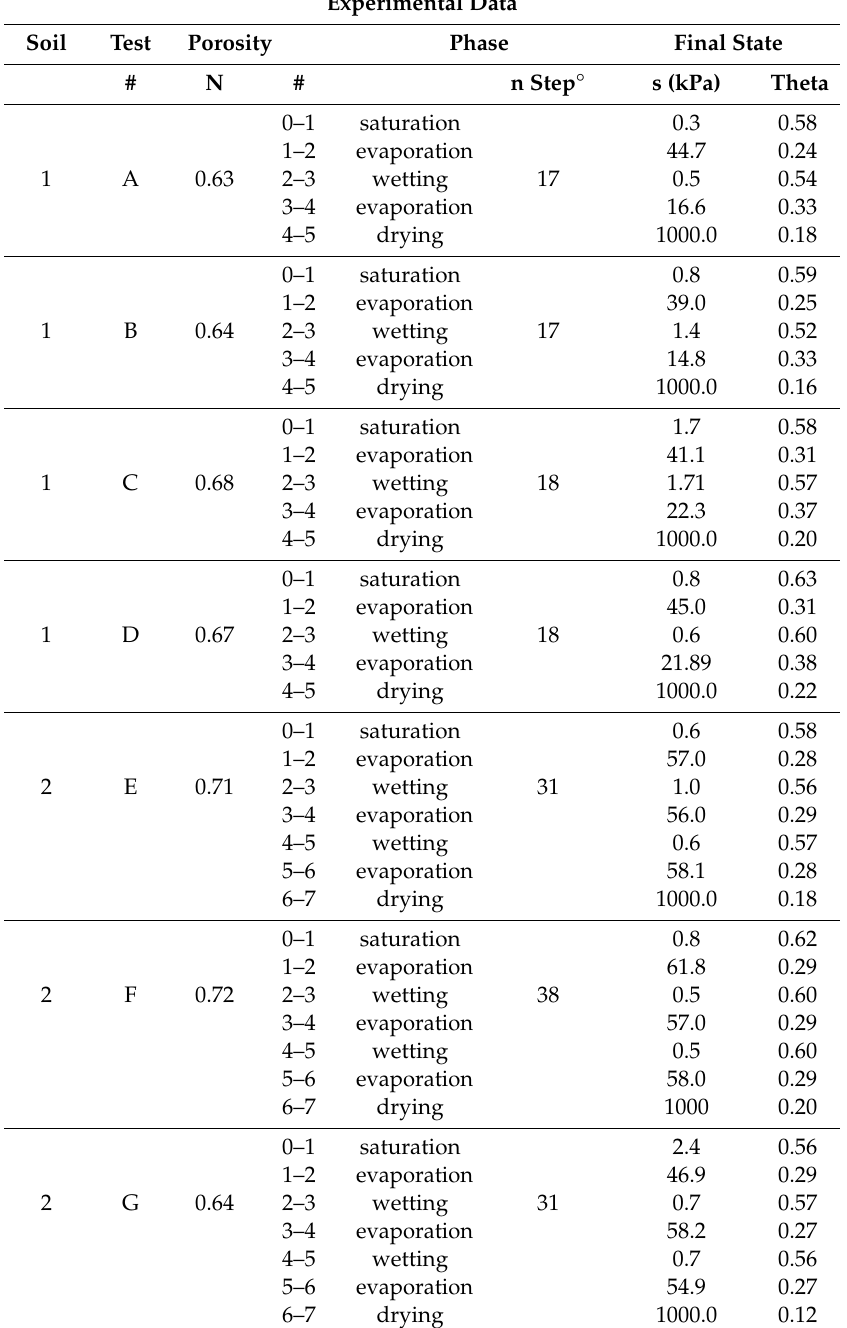
Table 2. Tests carried out in the laboratory: saturation, evaporation, wetting, and drying cycles. Experimental